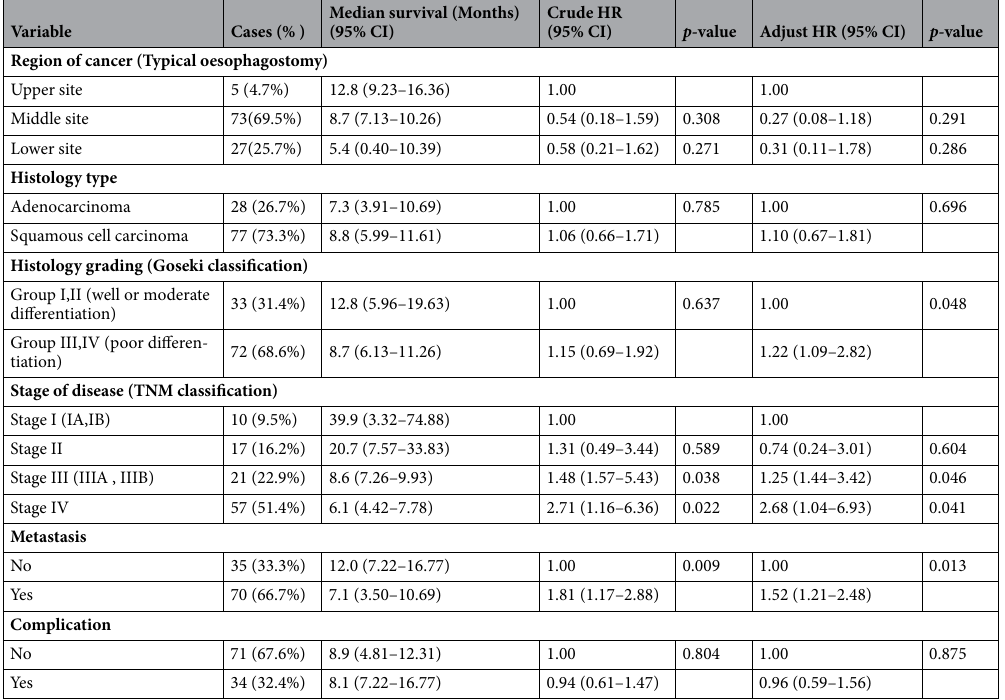
Table 3. Association between clinicopathological factors and EC prognosis. Oesophageal cancer (95% CI): 95% confidence interval, HR hazard ratio, adjust for age, gender, BMI and comorbidity by using Cox proportional hazards regression models. p -value from partial likelihood ratio test.